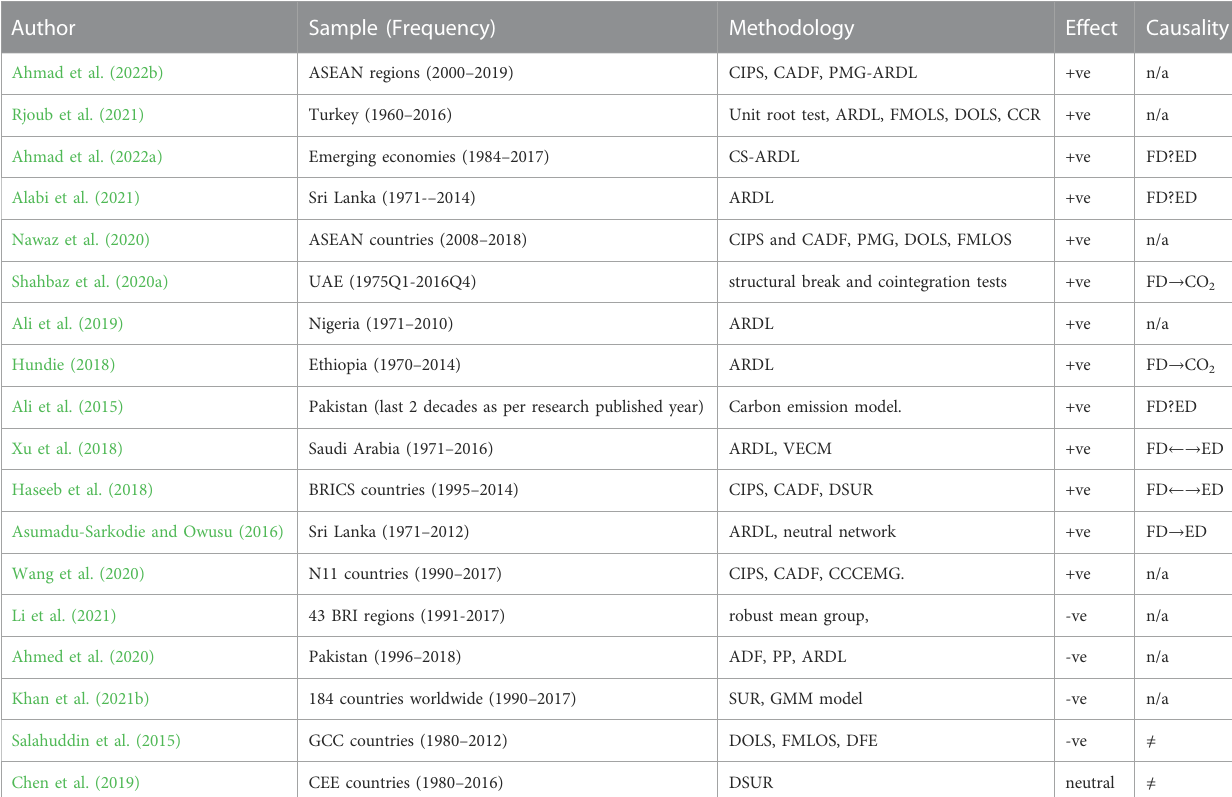
TABLE 1 Summary of literature survey: FD-led